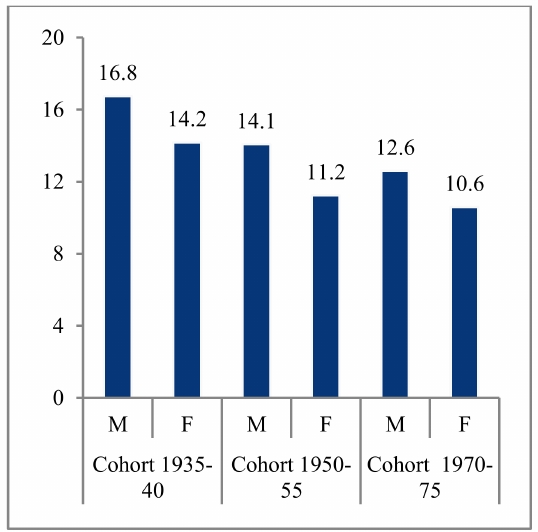
Figure 1. Range between first and last transition for those who experienced at least 4 transitions up to 35 years of age, by cohort and gender.